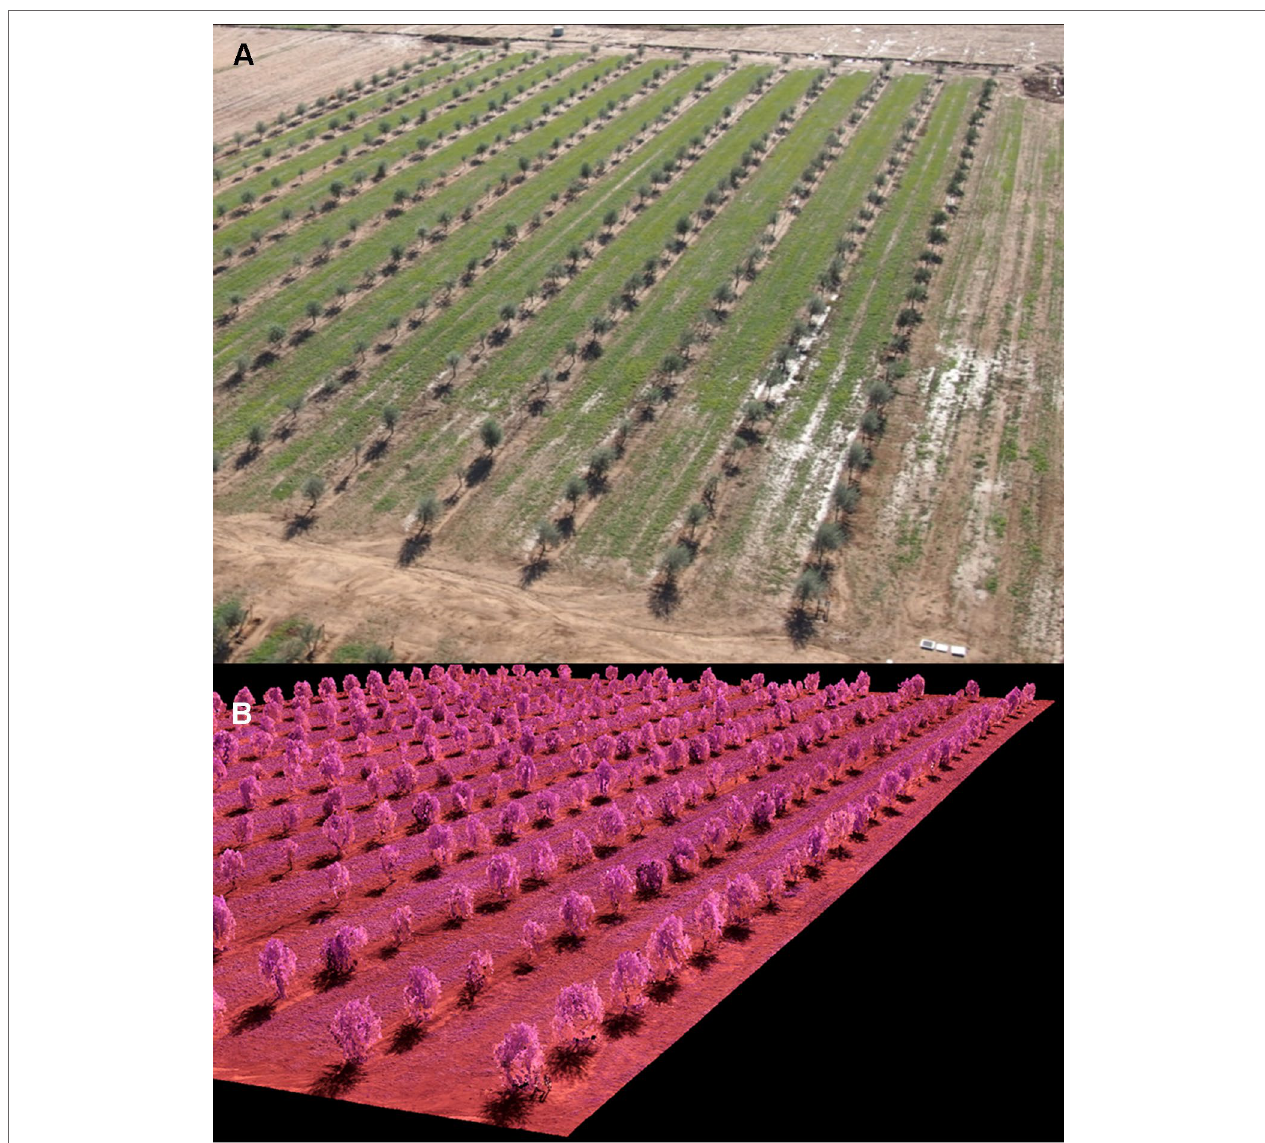
FIgUrE 3 | (A) General View of the Intensive Field Trial-2018; and (B) Partial View of the Corresponding 3D Point Cloud Produced by the Photogrammetric Processing of the Remote Images Taken With the UAV Platform.